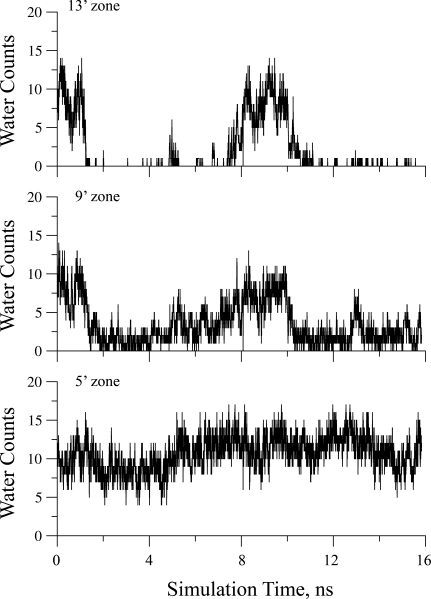
Number of Water Molecules in the Channel in Contiguous 6 Å Thick Zones Centered at TMD2 Positions 5′, 9′, and 13′ Plotted against Simulation Time (Trans-Membrane Potential, −100 mV)